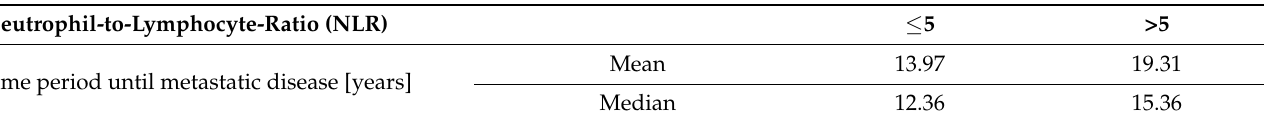
Table 5. Time period until metastatic disease correlated with neutrophil-lymphocyte-ratio (NLR) at the time of